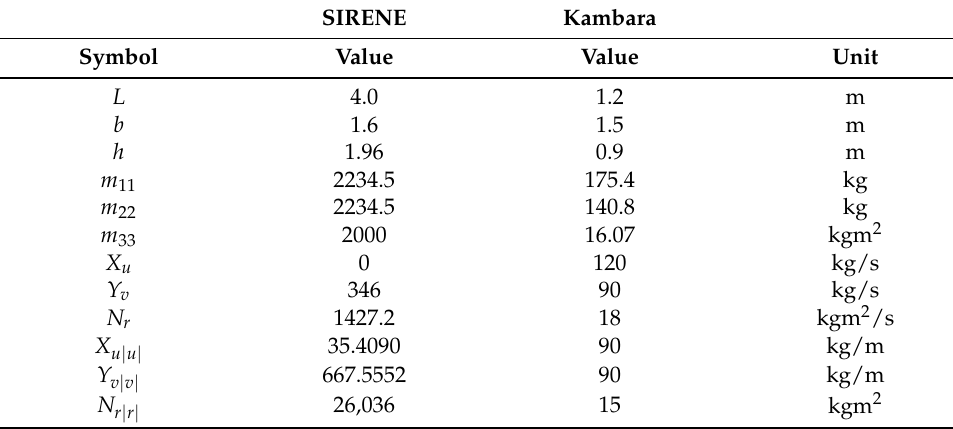
Table 1. Parameters of SIRENE and